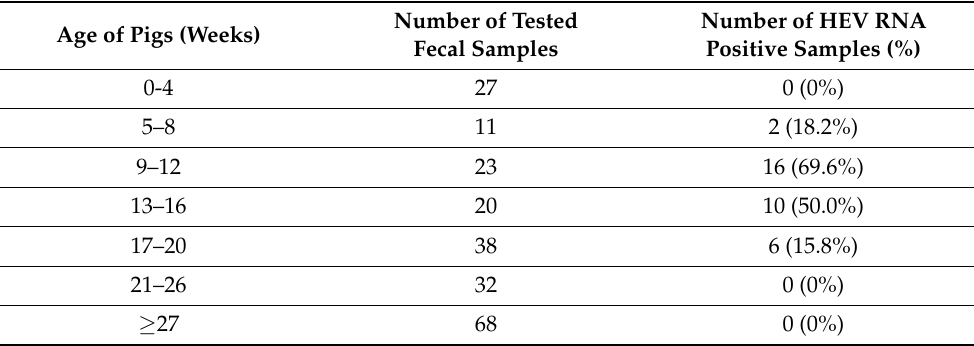
Table 2. Frequency of HEV RNA detection in individual fecal samples from pigs of different ages at one farm in Vladimir